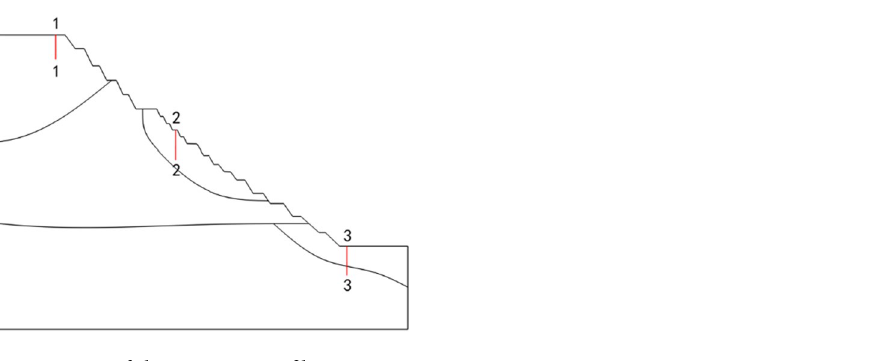
Figure 14. Locations of characteristic